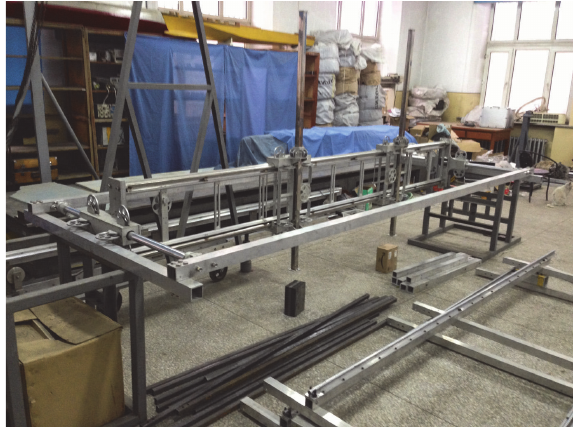
Figure 4: Four-degree-of-freedom monitoring instrument.